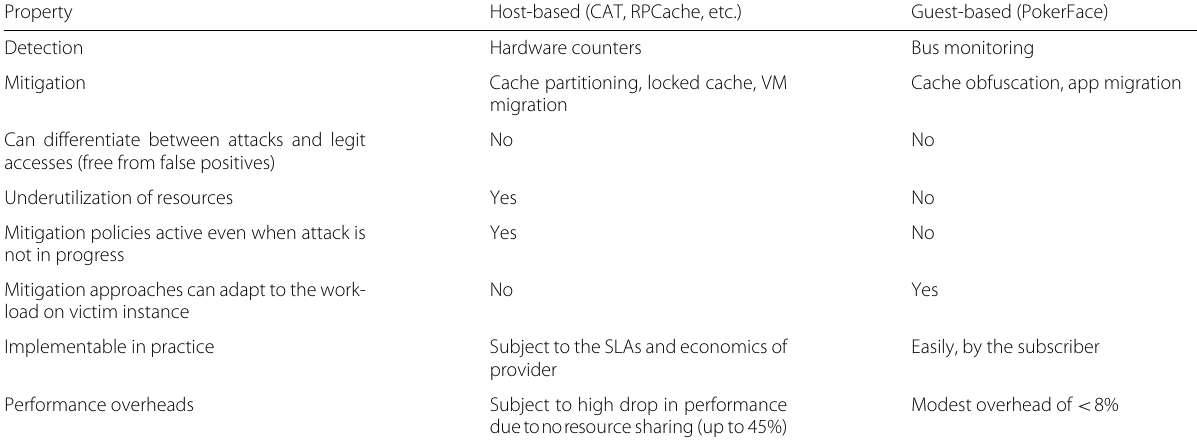
Table 4 A comparison of Host-based and Guest-based solutions against cache-based side channel attacks Property Host-based (CAT, RPCache,